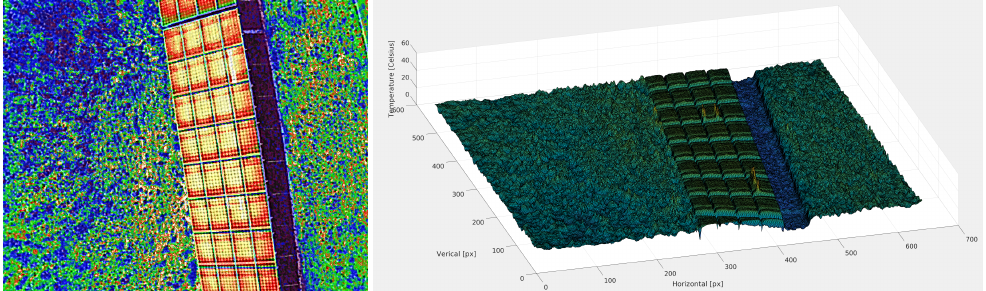
Figure 10. Example infrared image created with DJI Zenmuse XT2 ( left , note that the vertical axis of the image is pointing downward), and temperature distribution extracted from the image metadata ( right